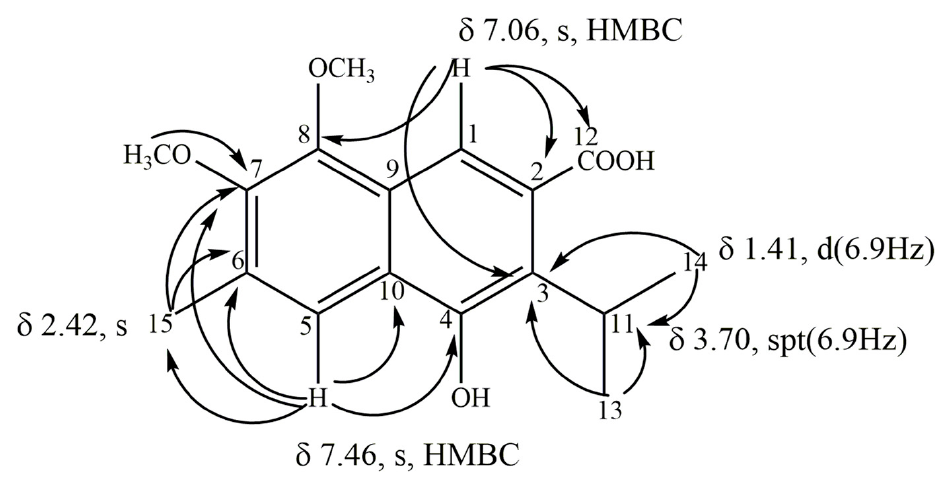
Figure 3. HMBC correlations of compound 7, named 8-methyl-iso-sphaeralcic acid. Based on an analysis of the spectroscopic data of single and two-dimensional NMR